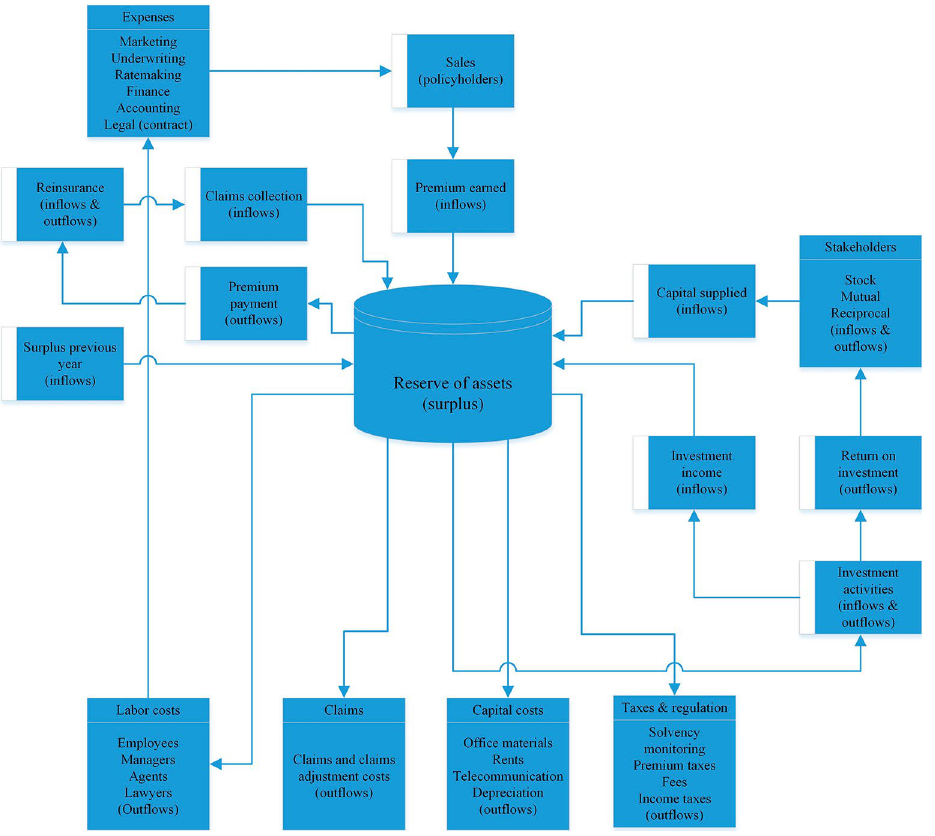
Figure 1. Insurance cash flow as a financial intermediary (source: retrieved and modified from Brockett et al. 2005,